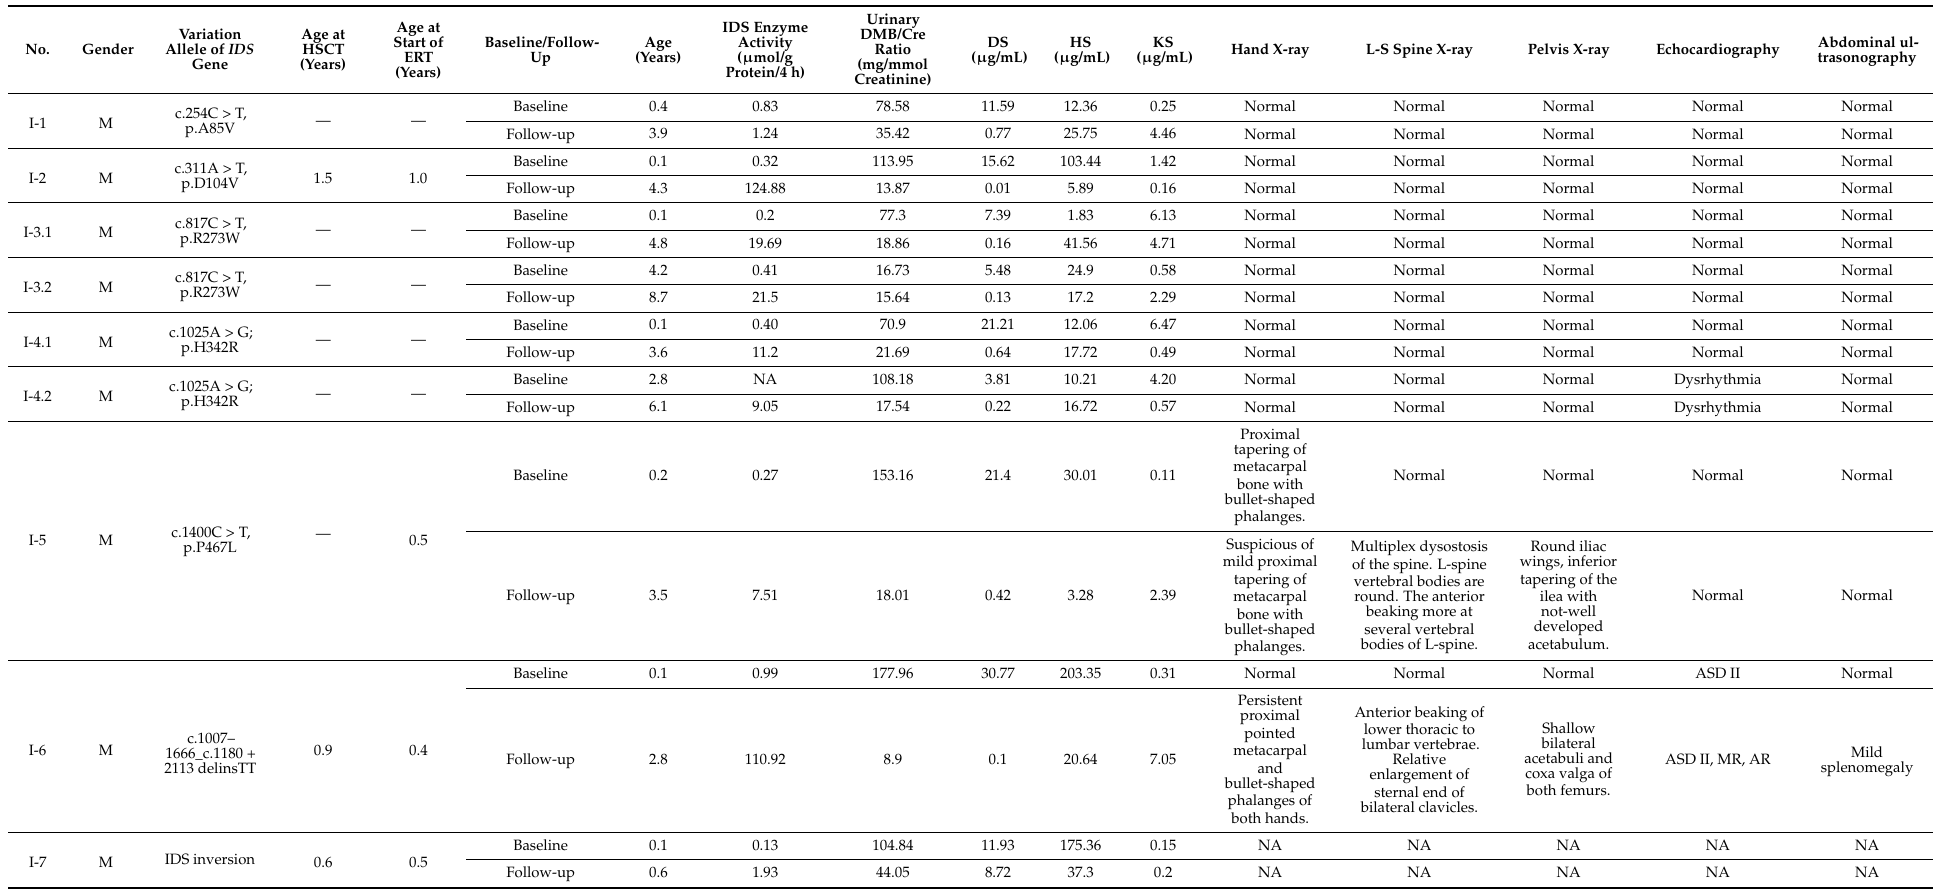
Table 2. The baseline and long-term follow-up data of Group 1 (confirmed MPS II). We chose one subject with the longest follow-up time with each IDS gene variant as the representative example.